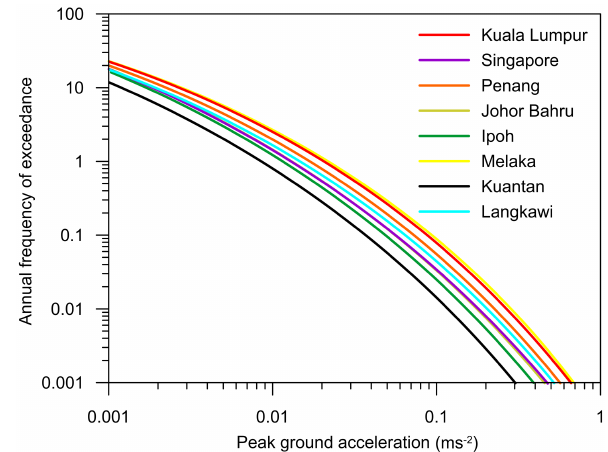
Figure 12. Hazard curves for different cities in Peninsular Malaysia and Singapore at rock